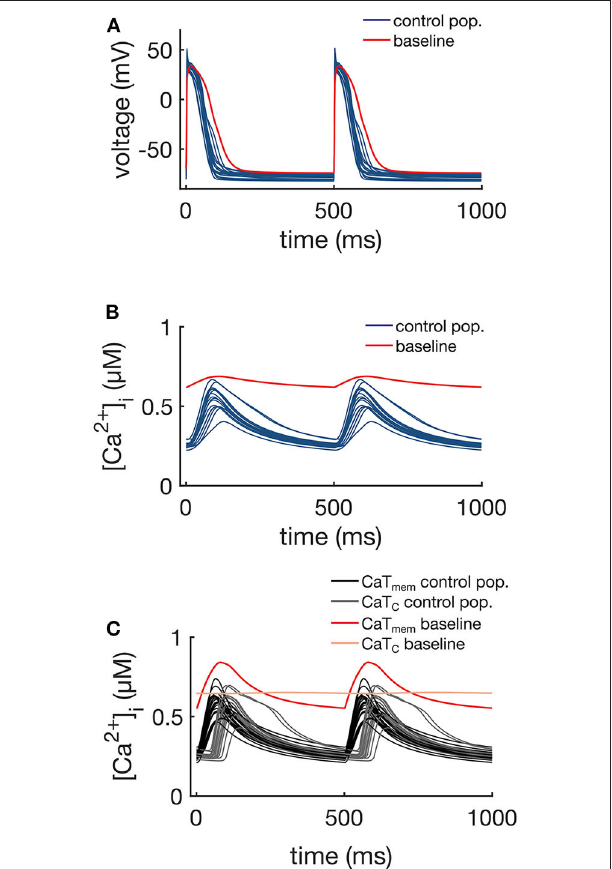
FIGURE 4 | APs (A) , whole-cell CaTs (B) , and membrane (CaT m ) and center of cell (CaT c ) CaTs (C) of the control population (16 models), at 2Hz steady pacing. The red traces represent the baseline model with the original maximum conductances shown in Table 1